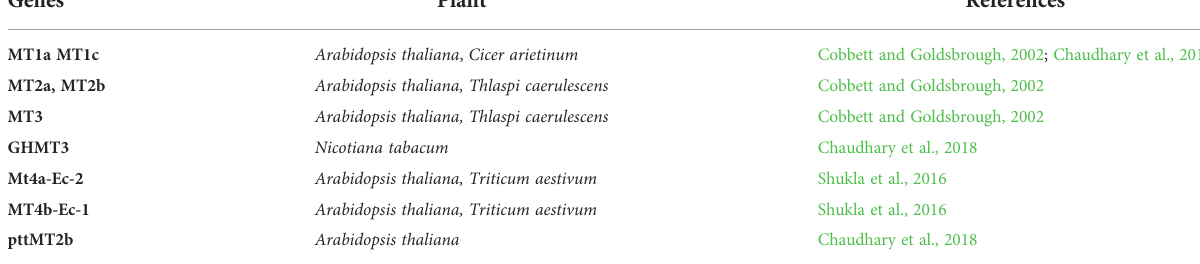
TABLE 3 The metallothioneins genes are involved in heavy metal tolerance.